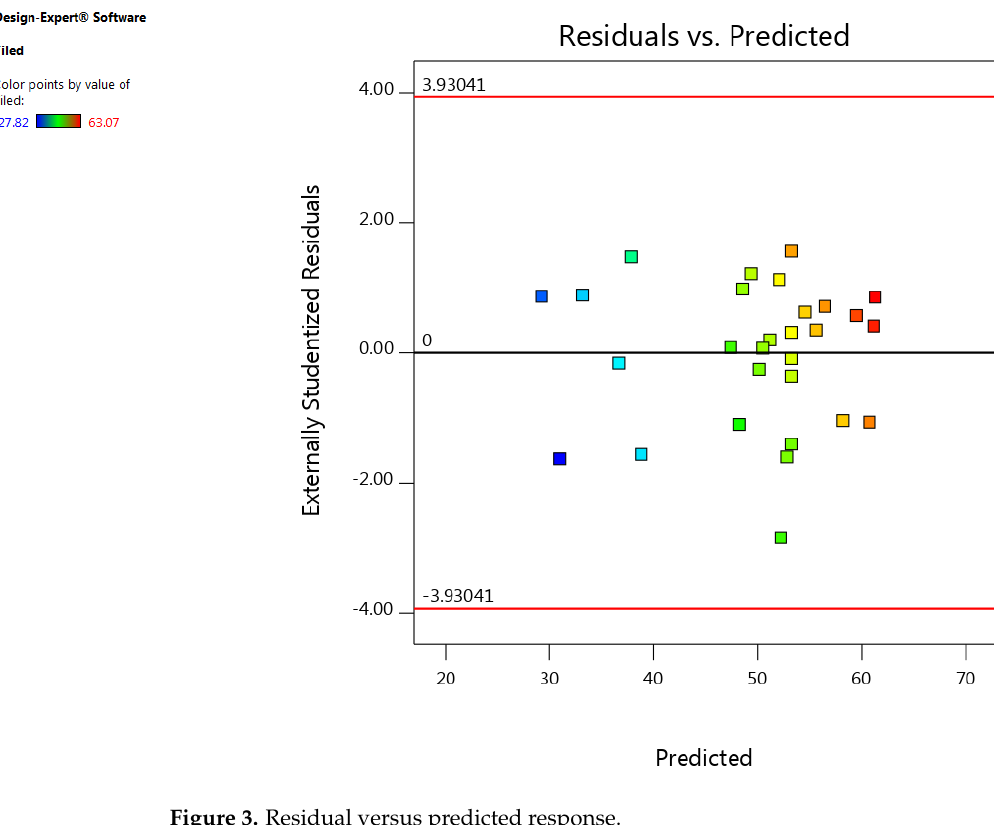
Figure 2. Actual experimental data versus predicted model.